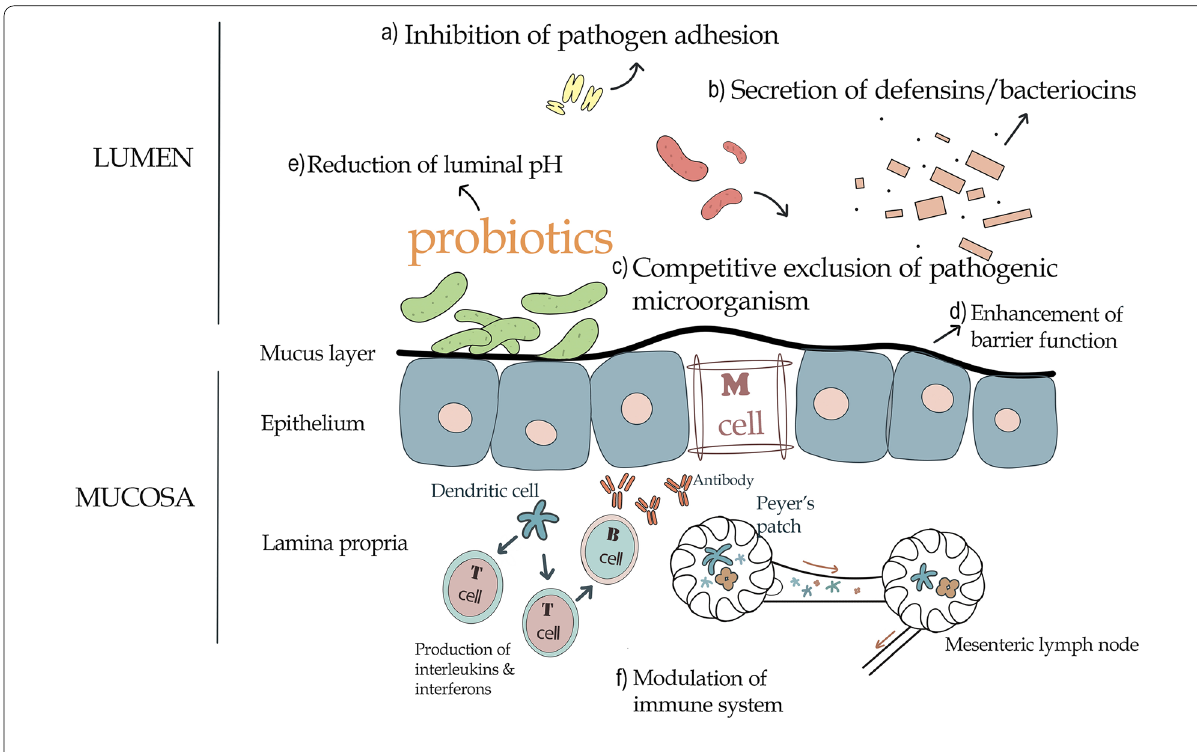
Fig. 1 Probiotic mode of action. These include six proposed mechanisms: a Inhibition of pathogen adhesion. Probiotics improve the growth rate against pathogenic microbes by suppressing pathogenic growth and diminishing pathogenic adhesion in the gastrointestinal (GI) tract. b Secretion of defensins/bacteriocins. Probiotics can intensify antimicrobial protein secretion like defensins to eliminate pathogens. c Competitive exclusion of pathogenic microorganisms. Probiotics can rigorously compete with intestinal harmful microbes to prohibit detrimental colonization by binding with receptors in the IEC or mucus layer. d Enhancement of barrier function. Probiotics can improve mucin glycoproteins secretion by the mucus-producing cells to yield a dense mucus layer that helps to decrease intracellular permeability to pathogens. e Reduction of luminal pH. Probiotics lessen the pH level of the lumen by triggering acetic acid production which is deadly to other pathogens. f Modulation of the immune system. Probiotics modulate innate immunity and adaptive immunity by T and B-cell activation through the dendritic cell in the mucosa. Dendritic cell is found in the mucosal lamina propria, surface epithelium and Peyer’s patches. The M-cells are highly specific epithelial cells and they take up probiotics in the Peyer’s patches. Dendritic cells supply them to the mesenteric lymph node where the T-cells and antibody-producing B-cells are